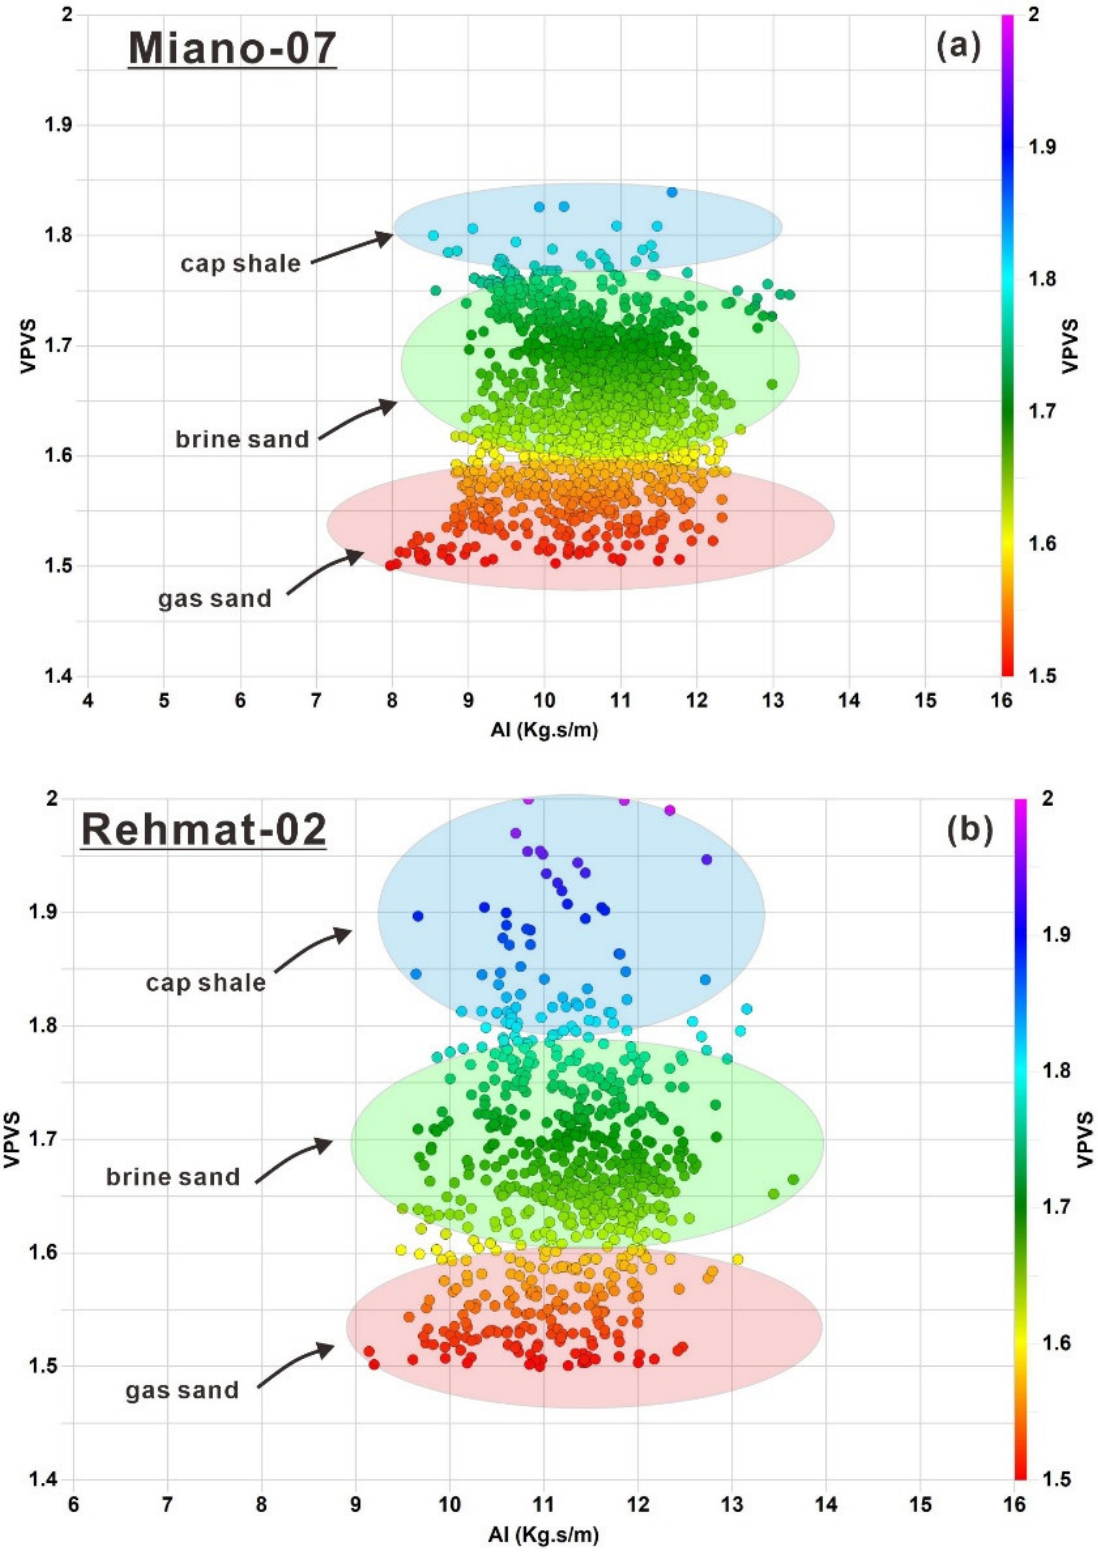
Figure 11. The RPT across V p /V s versus AI of ( a ) Miano-07 and ( b ) Rehmat-02 wells at the targeted intervals to showcase the gas-saturated (red box), brine sand (green box), and cap shale (blue box) zones.